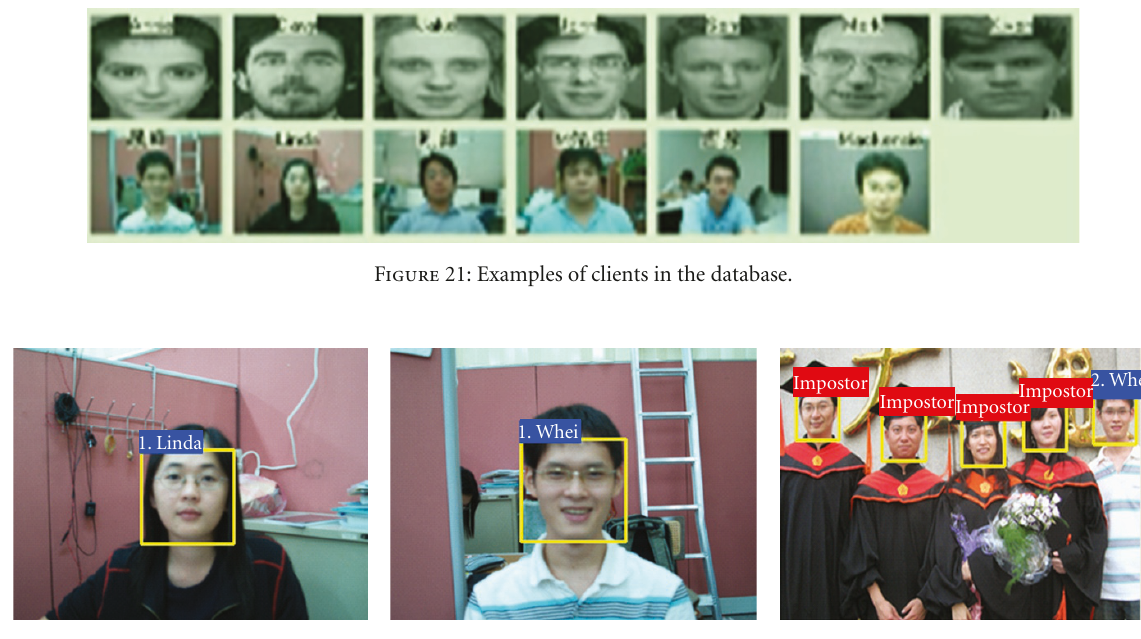
Figure 22: The testing results generated from the proposed face identifier.